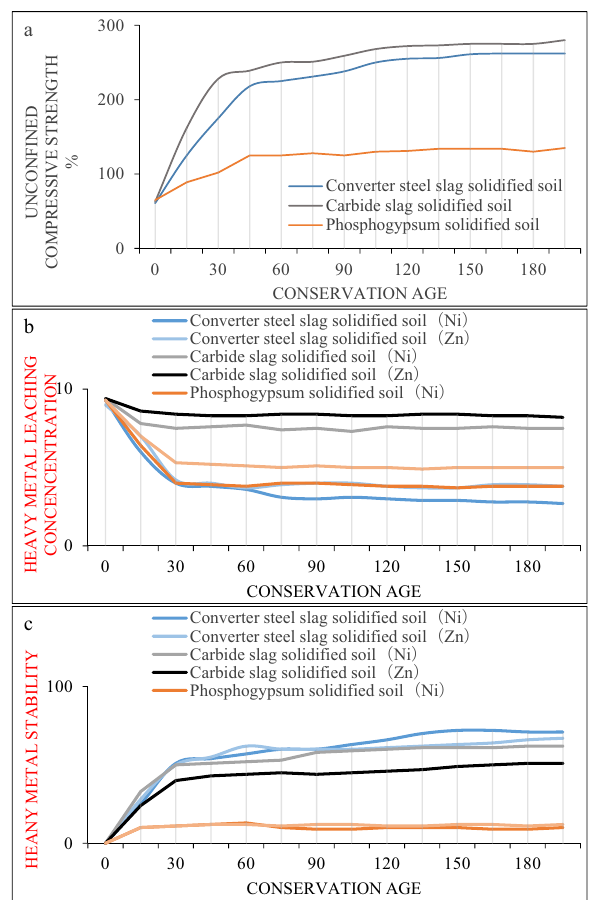
Figure 6. Unconfined compressive strength, heavy metal concentration, and heavy metal stability rate of BCP raw material-solidified soil; ( a ) Unconfined compressive strength of solidified soil; ( b ) Stabilization rate and leaching concentration of heavy metals; ( c ) Stabilization rate of heavy metals.